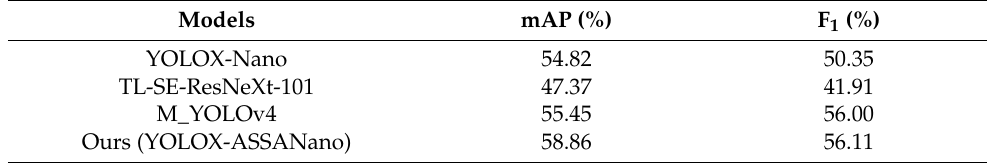
Table 8. Comparison results on